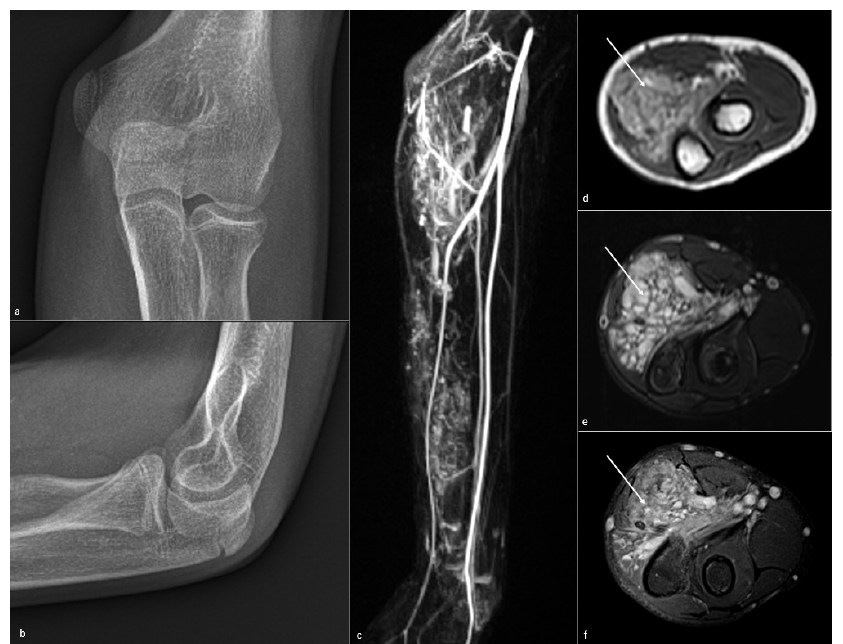
Figure 9. Vascular malformation of the forearm. Vascular malformation of the forearm causing elbow stiffness in a 12-year-old boy. ( a , b ) No phleboliths or bony anomalies are visible on radiographs. ( c ) Angio-MR sequence, ( d ) axial T1-weighted, ( e ) T2-weighted fat-saturated, and ( f ) T1-weighted gadolinium-enhanced fat-saturated show a fatty and heterogeneous lesion (white arrow), with high vascular enhancement, in the anterior forearm compartment.